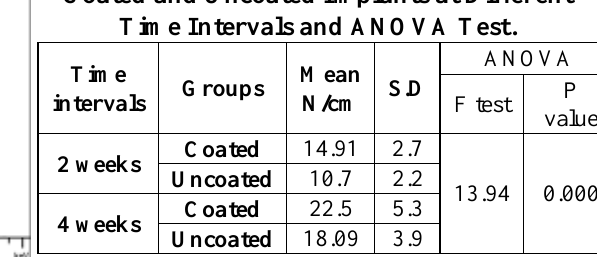
Figure 4: EDX-analysis of Al AgNo coatings on CpTi plate 3